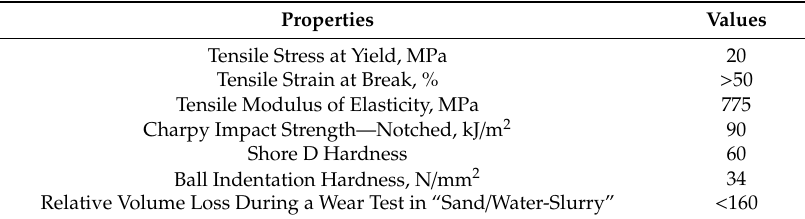
Table 7. Properties of the material used by “The Rubber Company”.